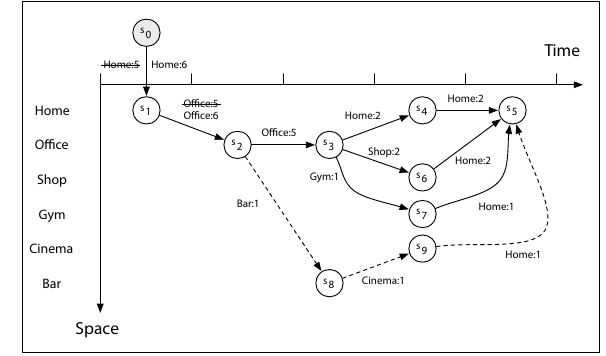
Figure 3: Example of matching of a sequence of